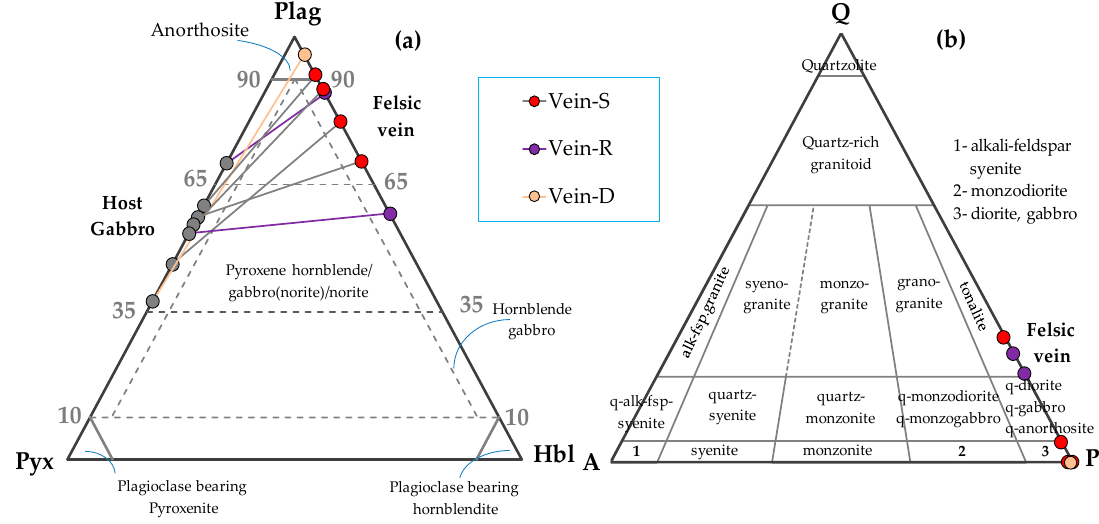
Figure 3. International Union of Geological Sciences (IUGS) classification of felsic rocks—Hole U1473A. ( a ) Plagioclase-pyroxene-hornblende classification scheme; ( b ) QAP diagram. Symbols with